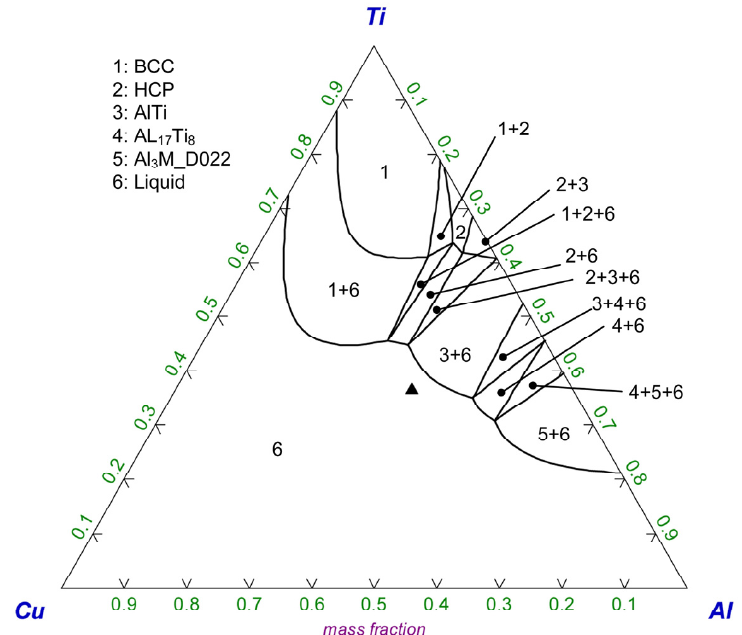
Figure 7. MP3 initial alloy (filled triangle) in Cu-Al-Ti phase diagram for 1300 °C as calculated in FactSage 7.3 [33].